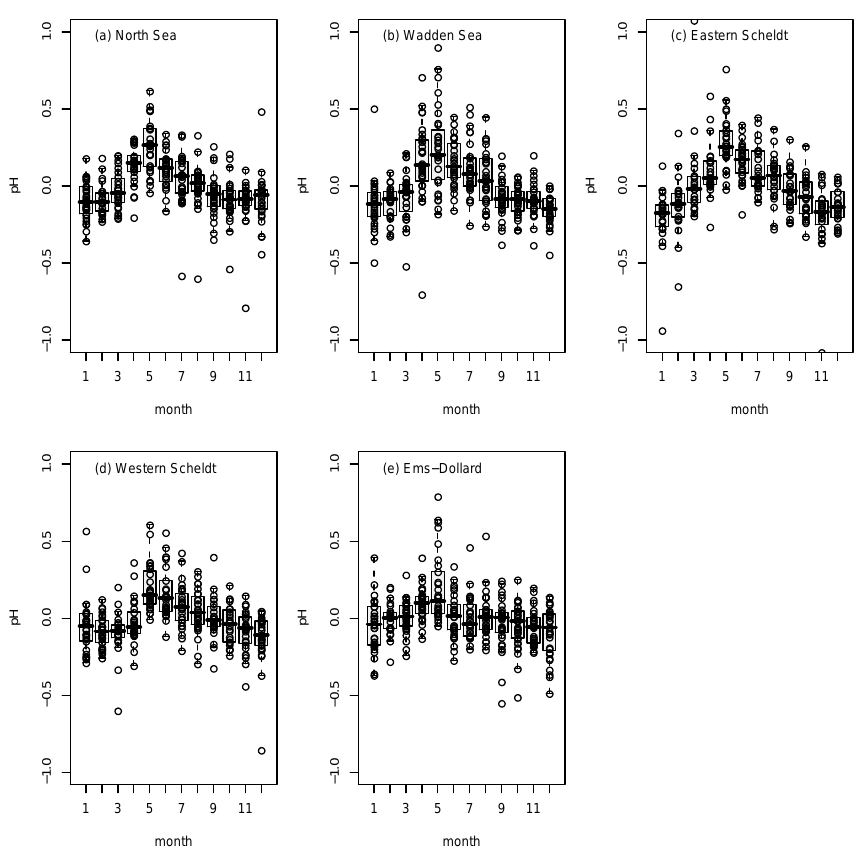
Fig. 6. Seasonal patterns observed at the selected stations. These values were calculated by substracting the long term signal (MODWT D6+D7+D8+S8) from the raw